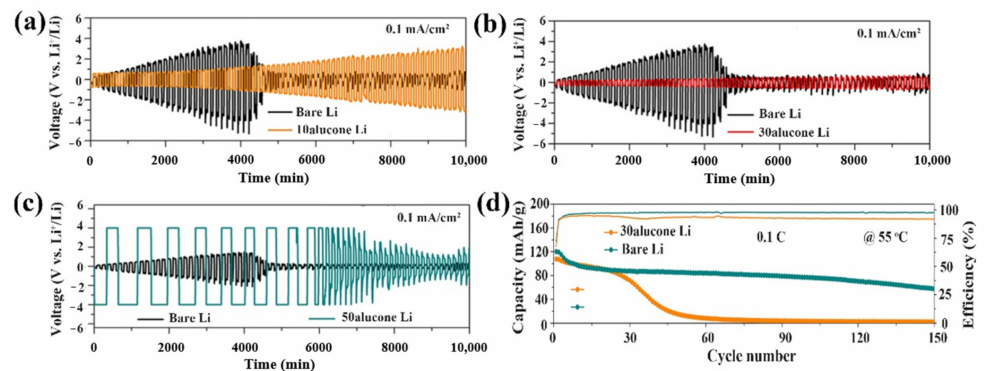
Figure 8. ( a – c ) Electrochemical performance for symmetric Li/Li 10 SnP 2 S 12 /Li cells